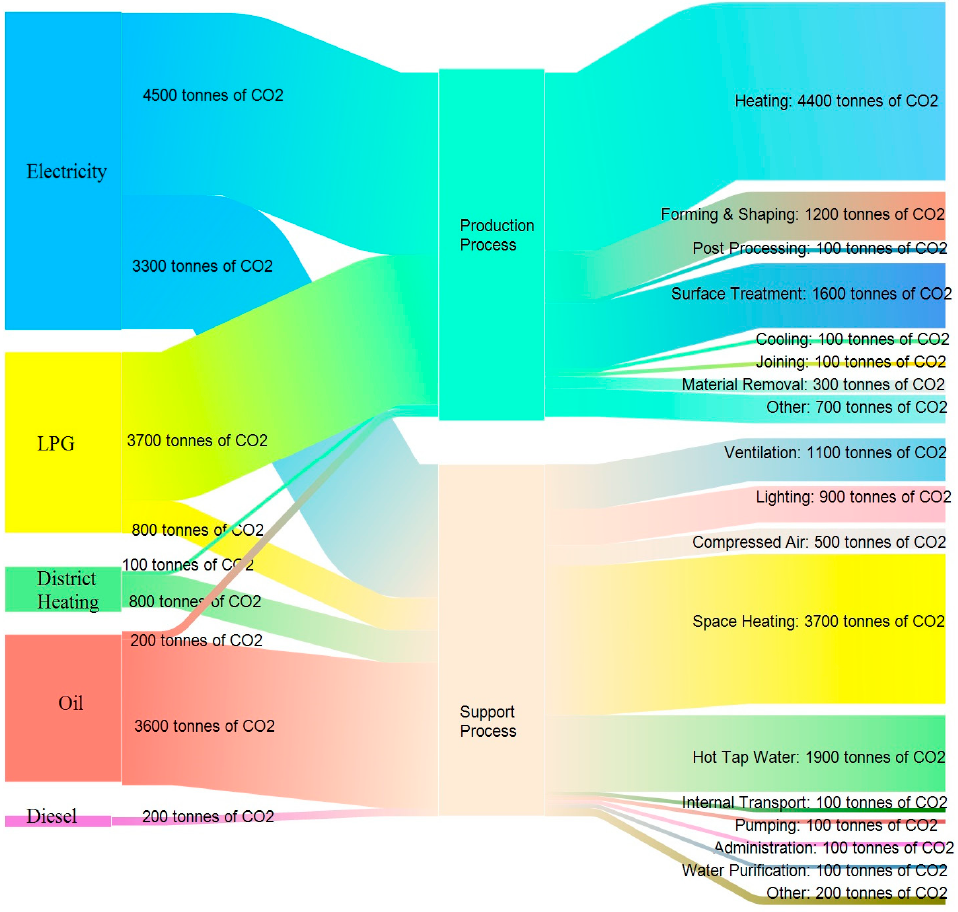
Figure 11. CO 2 emissions for each category at different levels of taxon in the Swedish engineering industry based on scenario 1, where average electricity mix and average district heating mix are considered (values are rounded to nearest 50 or 100).